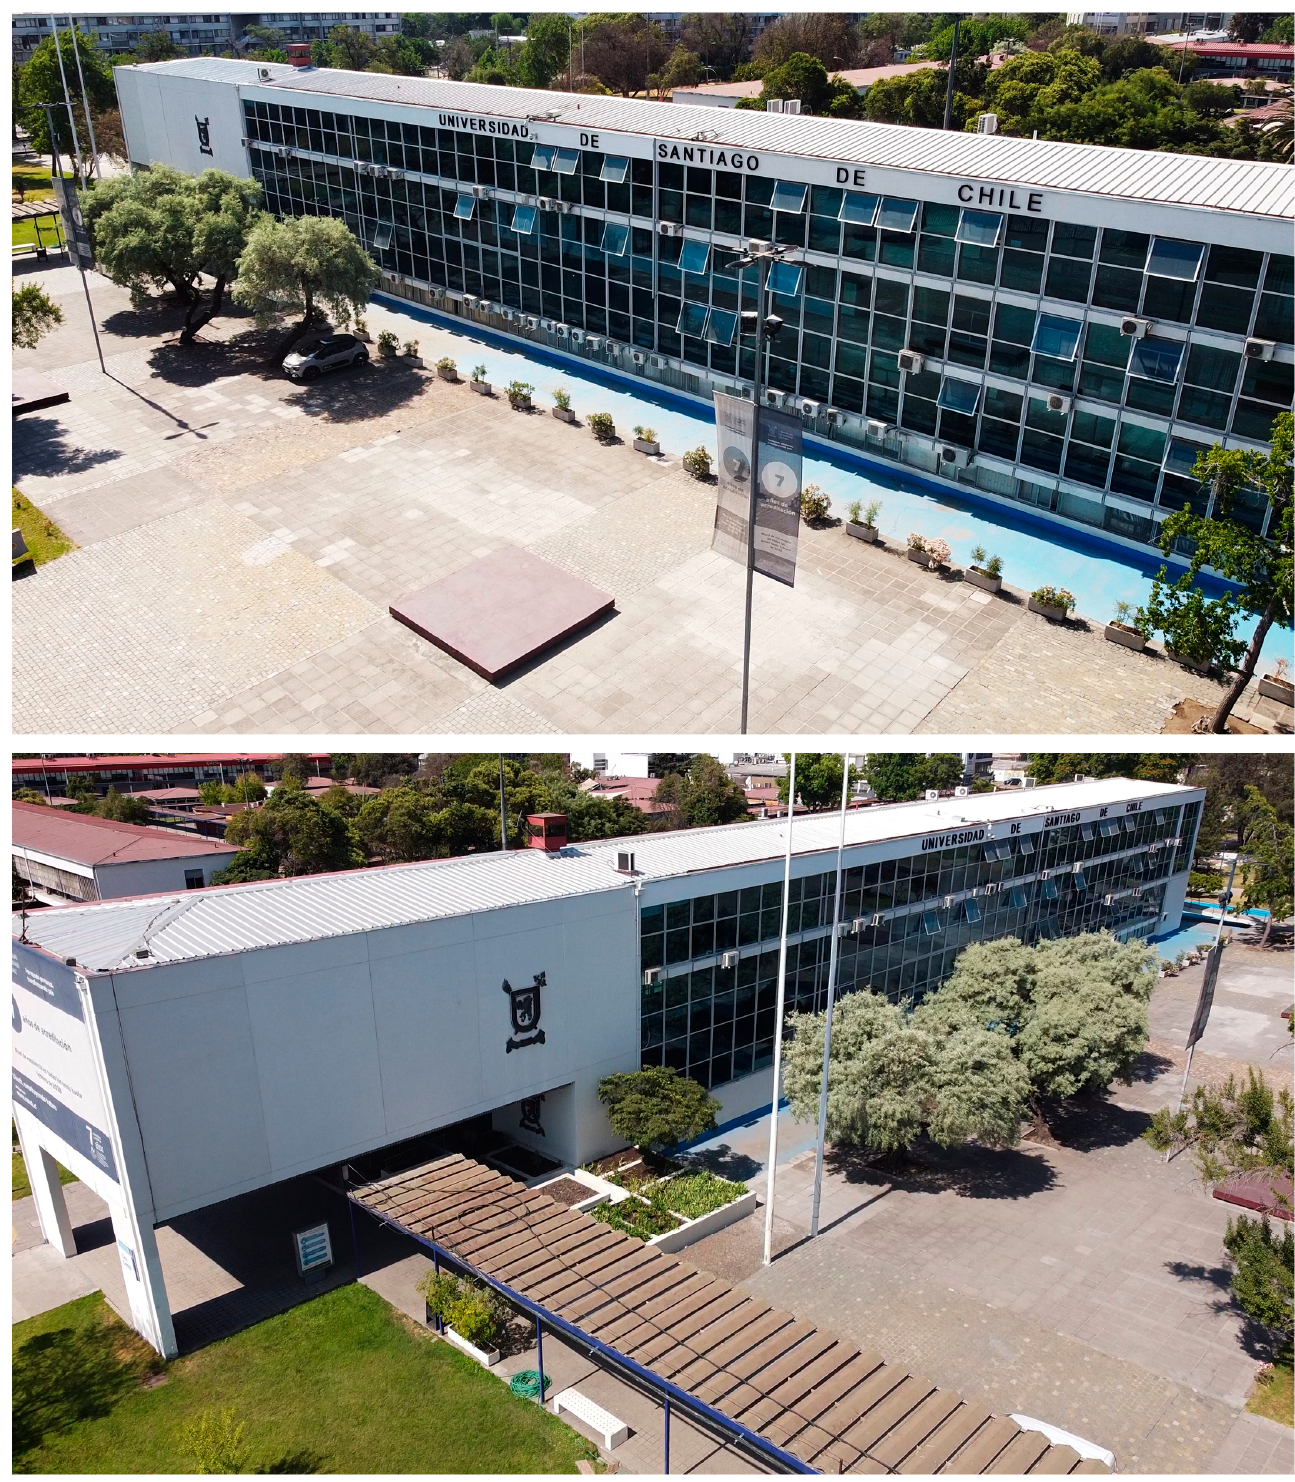
Figure 2. University of Santiago of Chile Headquarters.